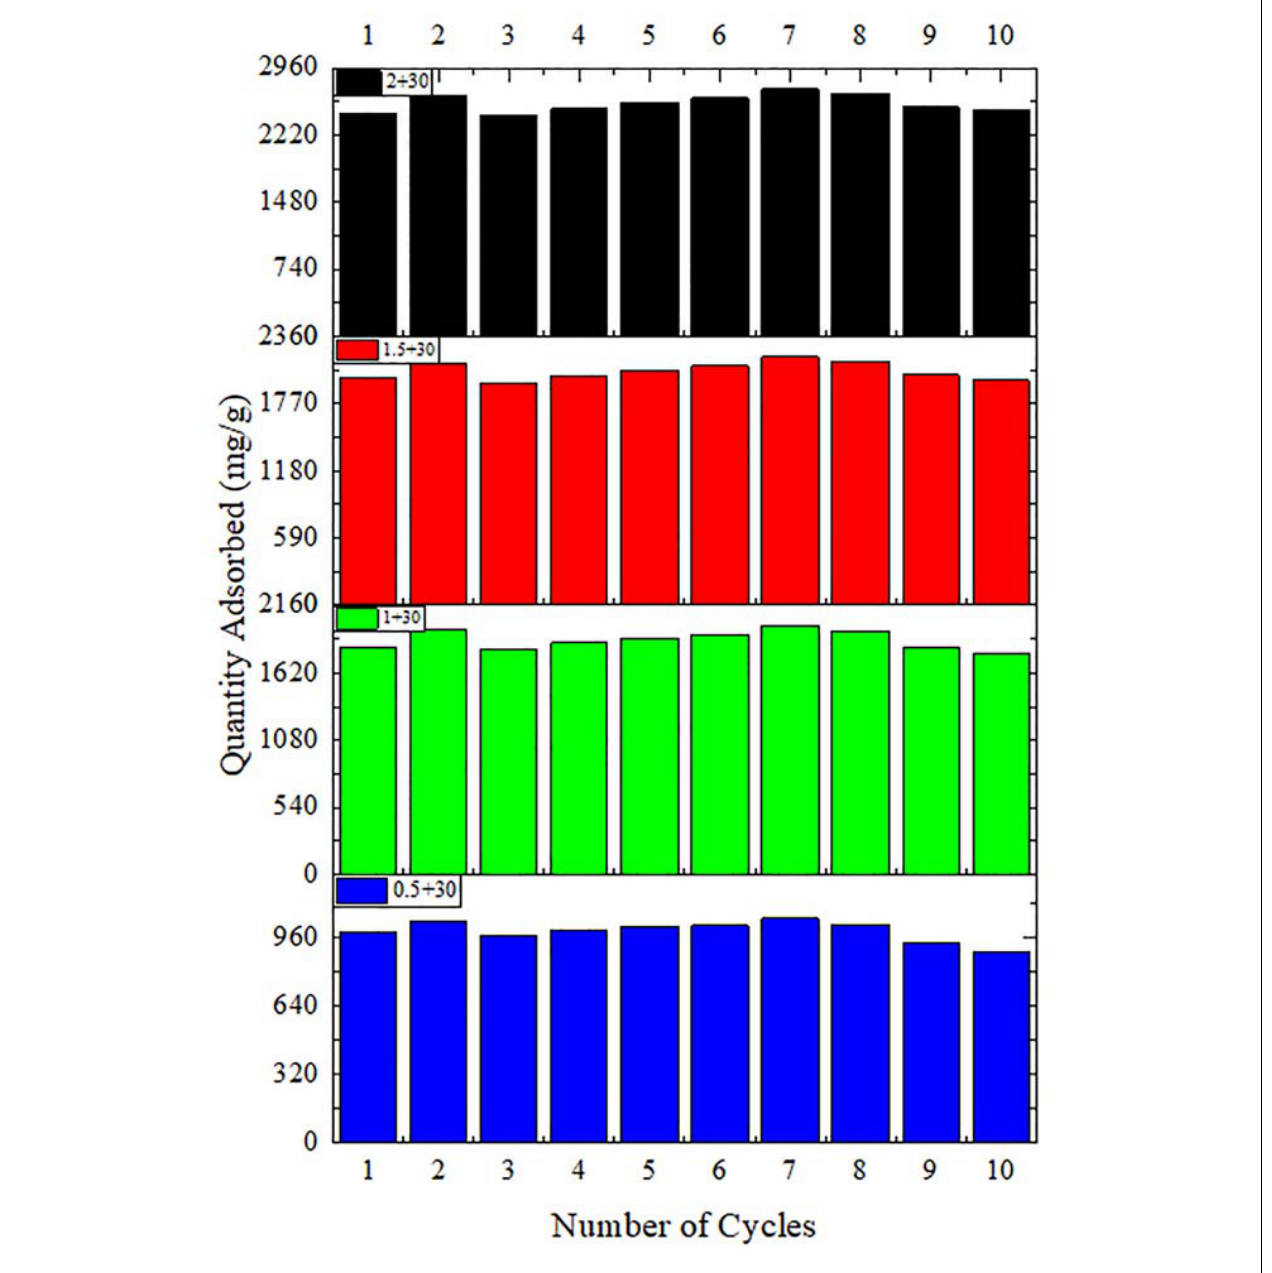
FIGURE 9 | Histogram of maximum water adsorption capacity of composites in 10 adsorption desorption